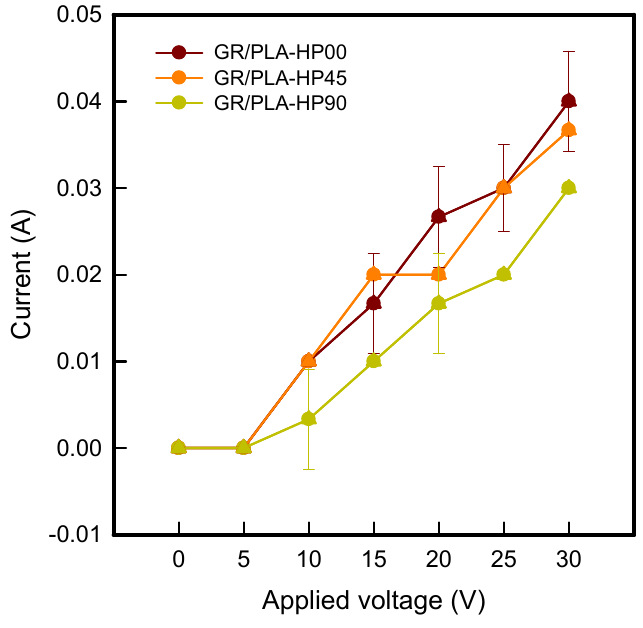
Figure 6. Current–voltage (I–V) of CFDM 3D-printed horseshoe pattern with di ff erent 3D printing directions.